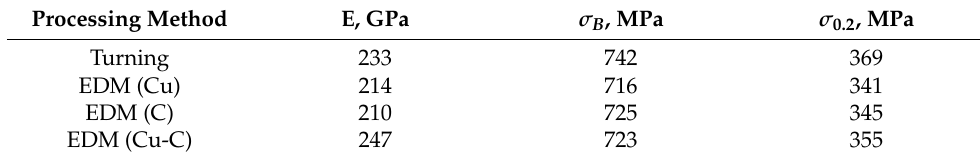
Table 8. Tensile mechanical properties of steel 15 depending on the processing method.